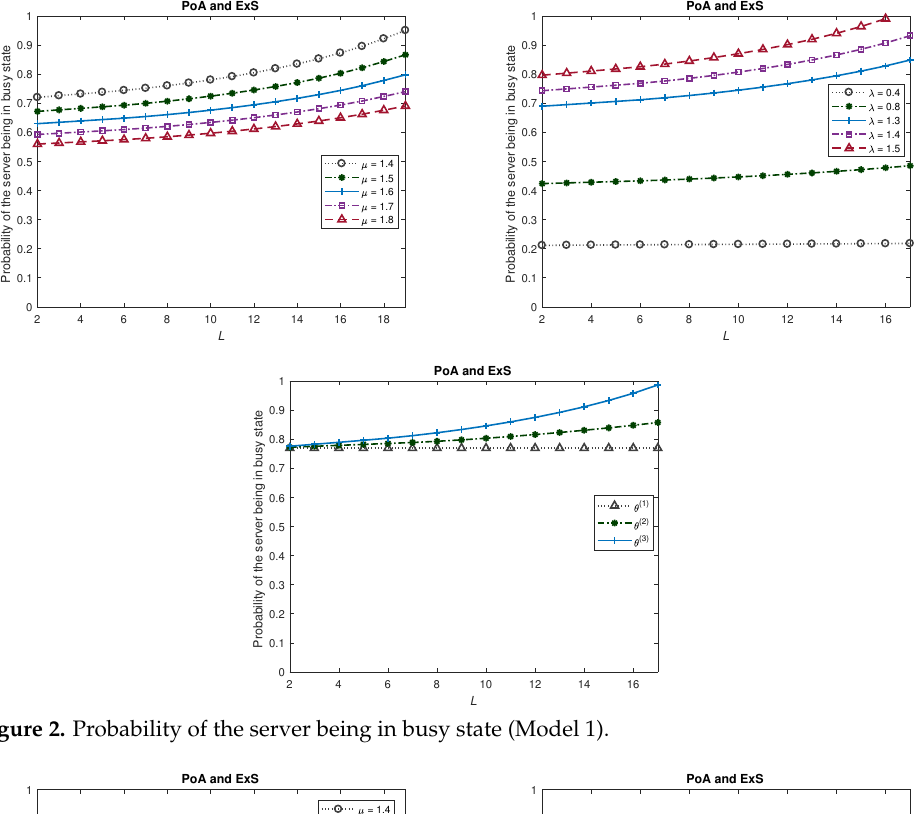
Figure 2. Probability of the server being in busy state (Model 1).